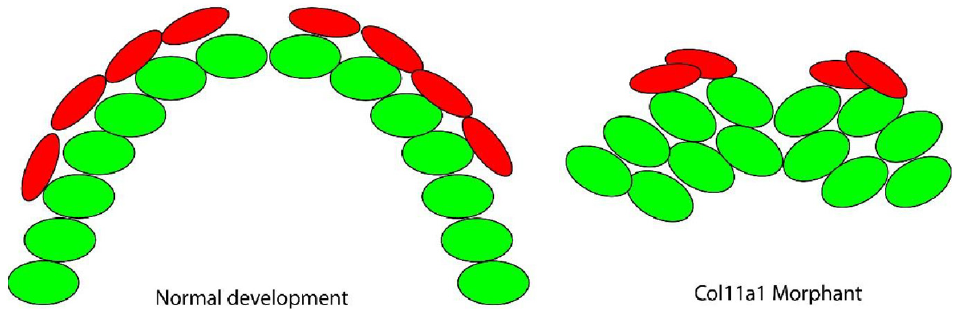
Figure 6. Model of Meckel’s cartilage mineralization in the col11a1a morphant. The organized chondrocytes (green) serve as a template for bone forming cells (red) to generate a calcified matrix. These cells extend along the template and form two bilateral mineralized rods. Therefore, perichondral cells cluster and produce abnormal mineralization at the cartilage template.